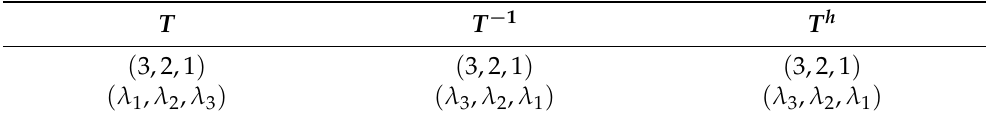
Table 2. 3-IETs without